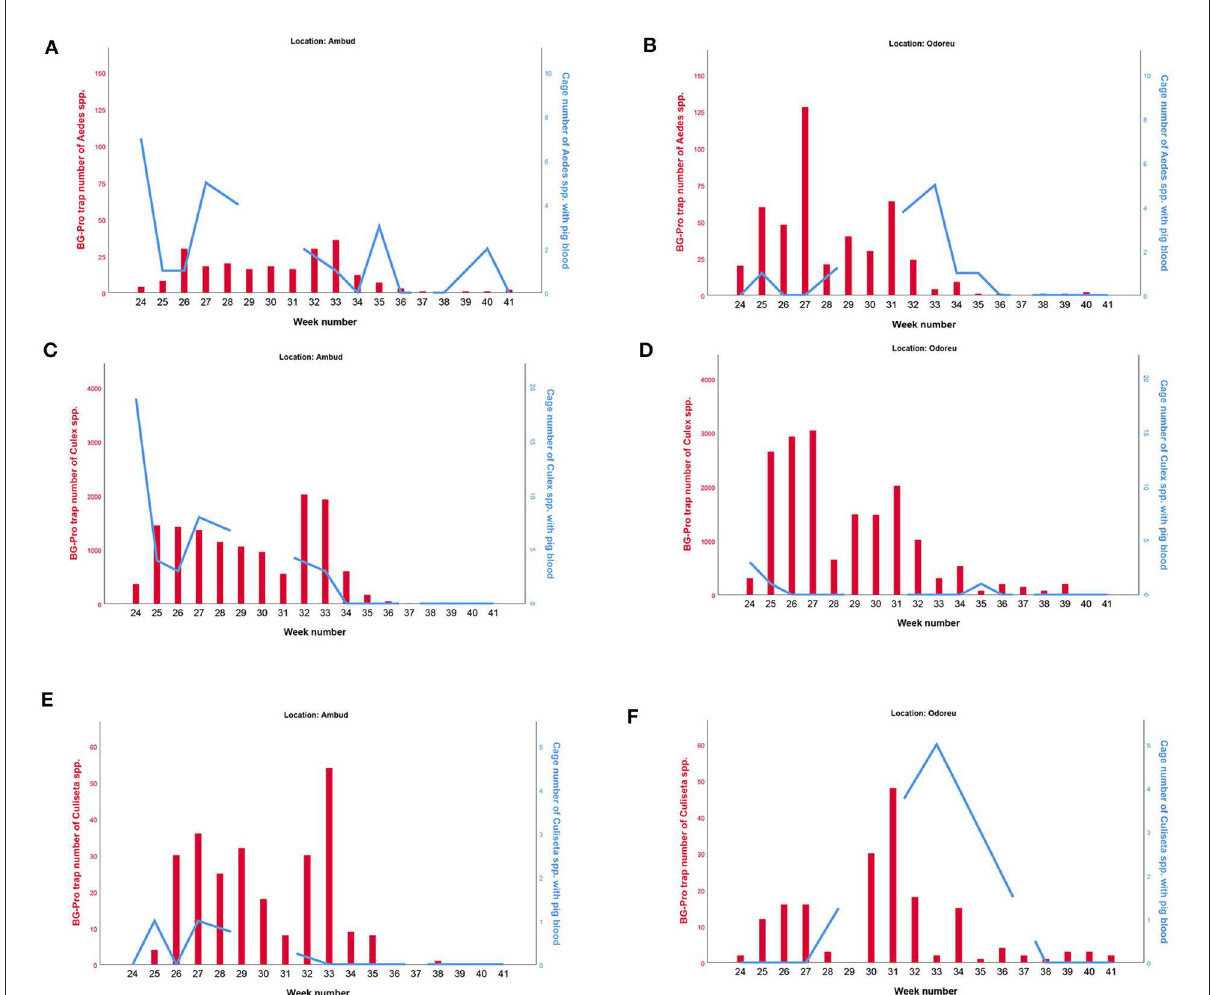
FIGURE4 Seasonal abundance of the different genera of mosquitoes caught in our BG traps (red bars and the left Y-axis), as well as the number of mosquitoes with pig blood of the specific mosquito genera in our cages (blue lines and the right Y-axis). Aedes spp. is shown in (A,B) , Culex spp. is shown in (C,D) , Culiseta spp. is shown in (E,F) . Ambud is shown in the left (A,C,E) and Odoreu is shown in the right (B,D,F) , both locations are situated in northwestern Romania. Note that the proportion of mosquitoes with pig blood are based on the sum of all the individual species caught for each genera, and only porcine-blood PCR-positive cases are included. Left and right Y-axes scales are not identical, and axes scales between the different genera are not identical. Anopheles are not included as we had too few observations to make any meaningful